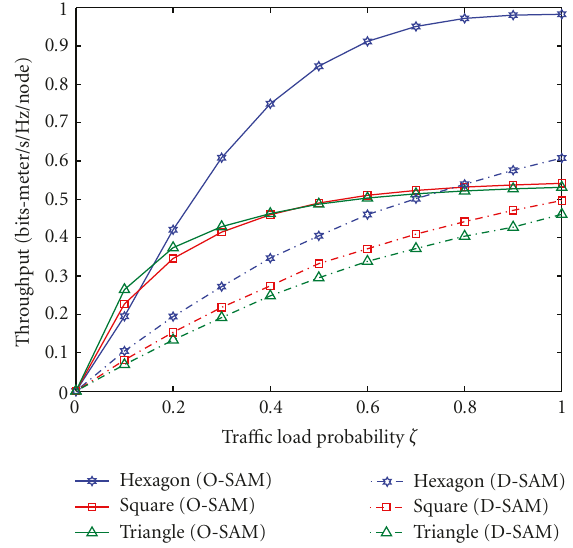
Figure 10: Throughput of O-SAM and D-SAM for di ff erent network topologies. We used ρ = 1, SNR = 40 dB, and 4 × 4 MIMO